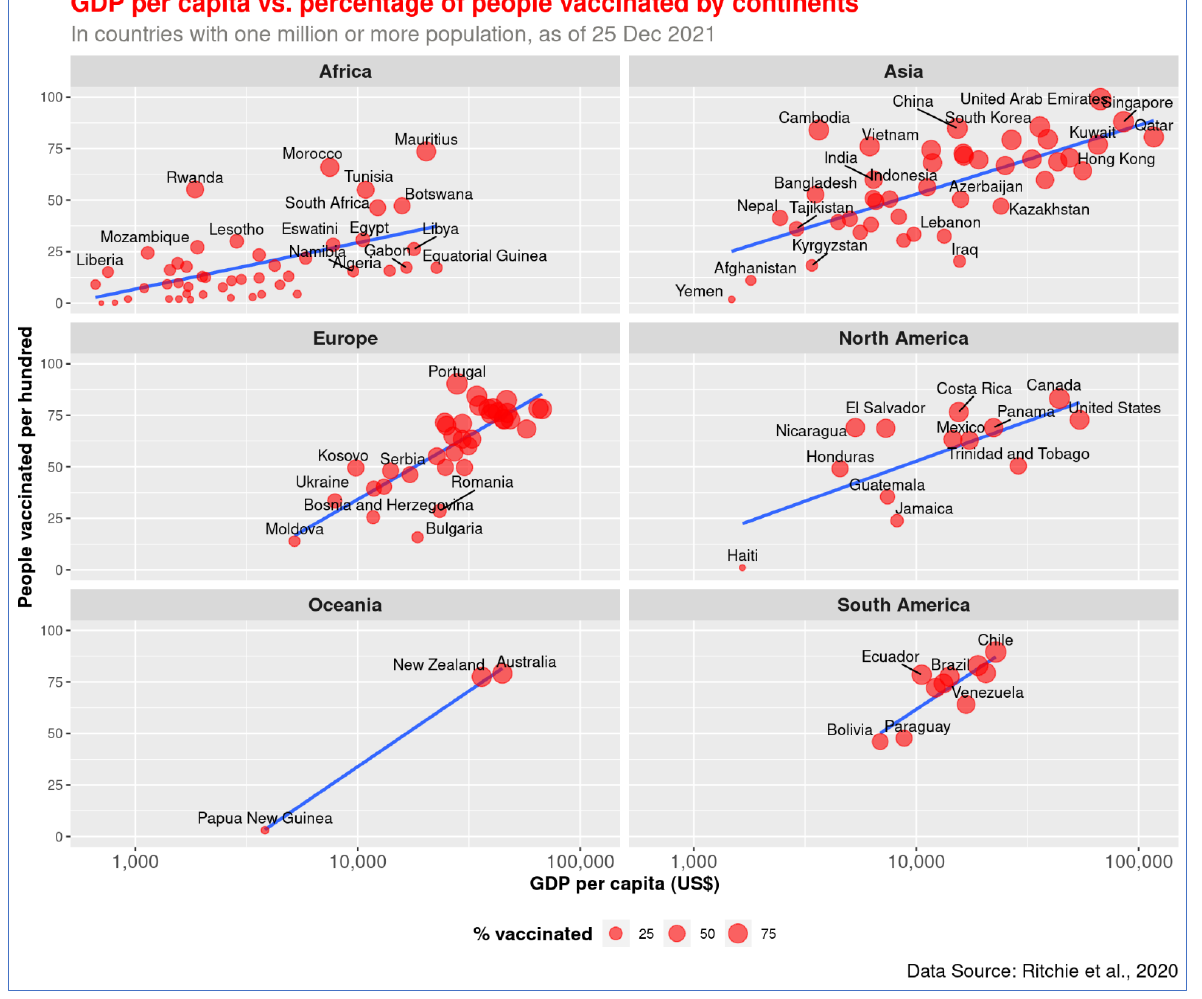
Figure 4. Association of GDP per capita and COVID-19 vaccination rate (full or partial) by continents. The figure shows that wealthier nations got higher vaccination rates on all continents. The highest level of disparity in GDP per capita and vaccination rate has been ob- served in Asia. While less-developed Asian countries like Yemen, Afghanistan, and Kyr- gyzstan vaccinated less than 20% of their population, more than five countries in the con- tinent achieved over 80% vaccination rates. India performed relatively better in immun- izing people compared to its wealth, and the country has achieved a vaccination rate of approximately 60%. Being a country with modest GDP, Bangladesh follows the trend but has made better progress in recent months. About 53% of the population of Bangladesh has received at least one dose of COVID-19 vaccine so far. UAE performed better than Kuwait, even though their national income level is similar. Yemen performed the worst in of any country in Asia.